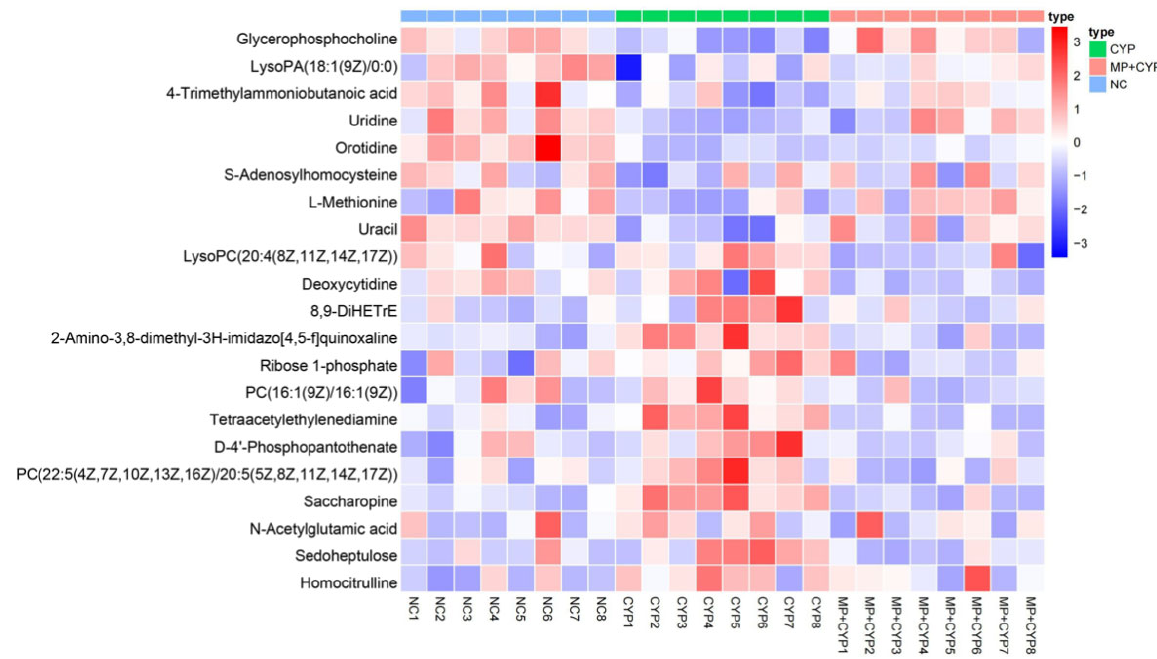
Figure 10. Cluster heat map of differential metabolites. Table 2. Differential metabolites in the liver and their change trends among groups.